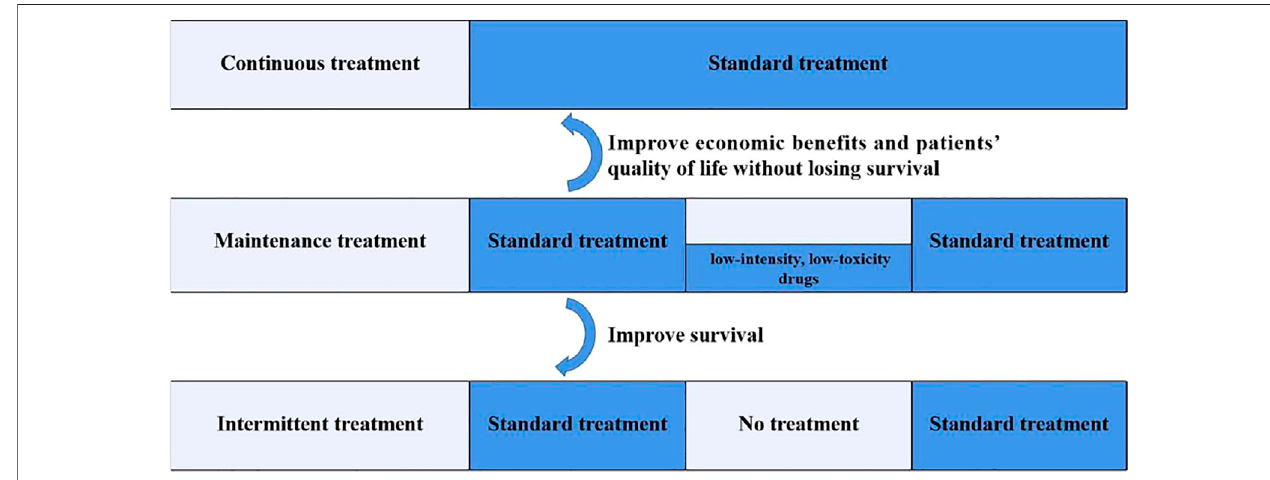
FIGURE 3 | Three treatment patterns after the standard fi rst-line treatment for mCRC. Maintenance therapy refers to the continuation of low-intensity and low- toxicity drugs after a period of fi rst-line treatment, when the optimal ef fi cacy is achieved and the disease is in a stable state. Continuous treatment means standard treatment until disease progression or intolerabletoxicity.Intermittent treatment refers to complete discontinuation of all treatments after a period ofstandard treatment. Compared to continuous treatment, maintenance therapy can improve the economic bene fi ts and patients ’ quality of life without losing survival. Compared to intermittent treatment, maintenance therapy can improve